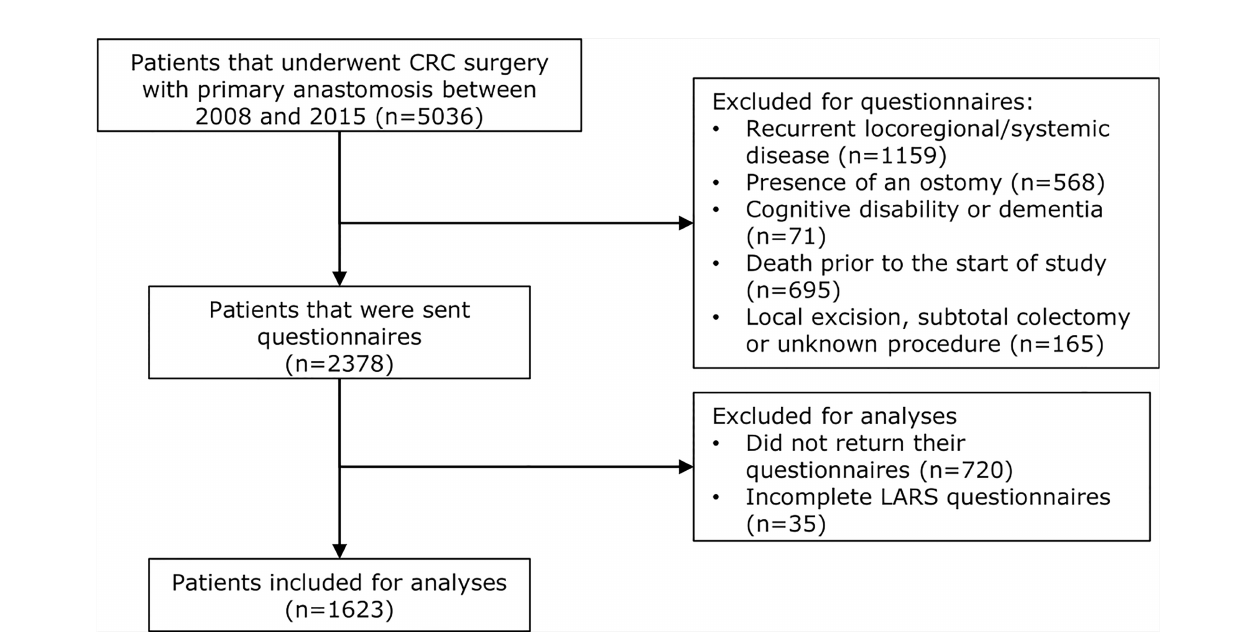
FIGURE 1 | Patient disposition fl owchart. Out of 5036 patients in total who underwent colorectal cancer surgery with primary anastomosis between 2008 and 2015, 2378 were sent questionnaires due to the inclusion and exclusion of patients based on the mentioned criteria. In total, 720 patients did not return their questionnaires and 35 patients returned incomplete LARS questionnaires. Overall, 1623 patients were included for analyses regarding LARS complaints and quality of